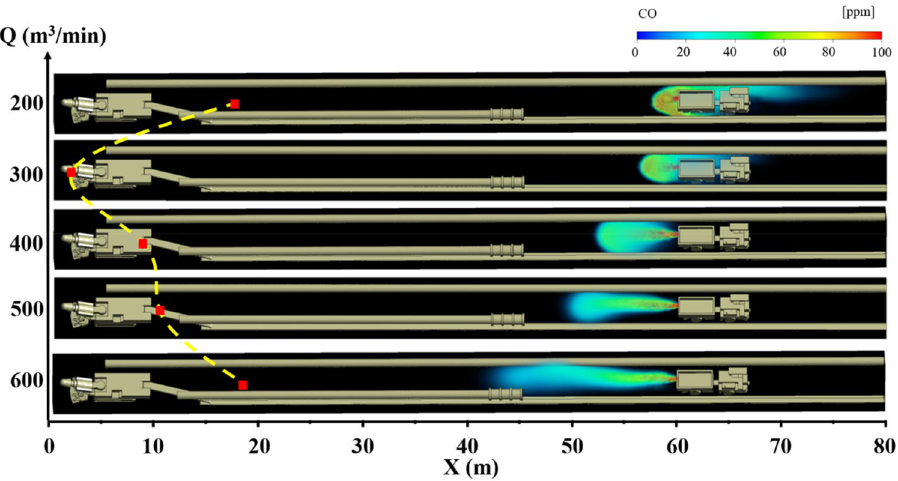
Figure 6. CO gas distribution under different air volumes Q when L = 60